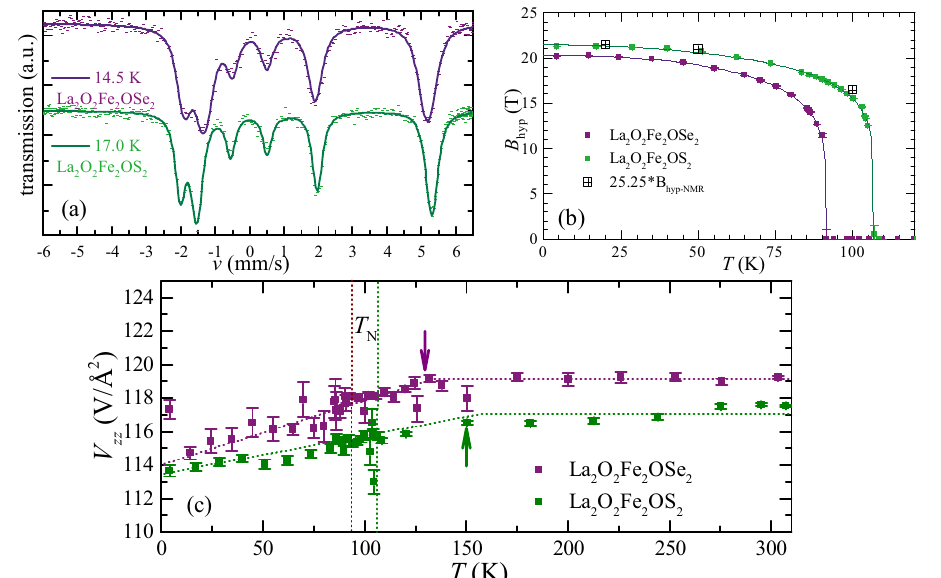
Fig. 4 Low temperature 57 Fe Mössbauer spectra and magnetic hyper fi ne fi eld. a Low temperature 57 Fe Mössbauer spectra of La 2 O 2 Fe 2 OSe 217 and La 2 O 2 Fe 2 OS 2 fi tted with the full static Hamiltonian as described in the text. A single sextet indicates full long-range magnetic order rapidly arising below T N . b Magnetic hyper fi ne fi eld B hyp or the magnetic order parameter determined from 57 Fe Mössbauer measurements. The lines denote the fi t of sublattice magnetization by using the equation M ð t Þ / B hyp ð T Þ / ð 1 (cid:2) T = T N Þ β crit . c The temperature dependence of the principal axis component V zz of the EFG decreases above T N for La 2 O 2 Fe 2 OSe 2 and La 2 O 2 Fe 2 OS 2 . Dotted lines are the guides to the eye.